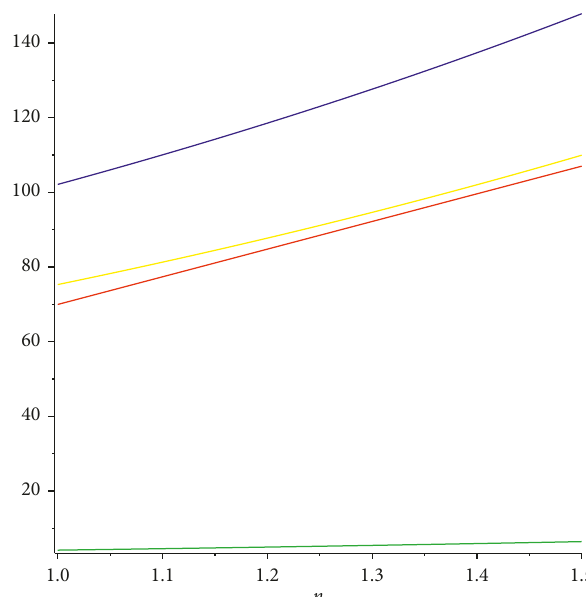
Figure 19: IRD1 of D